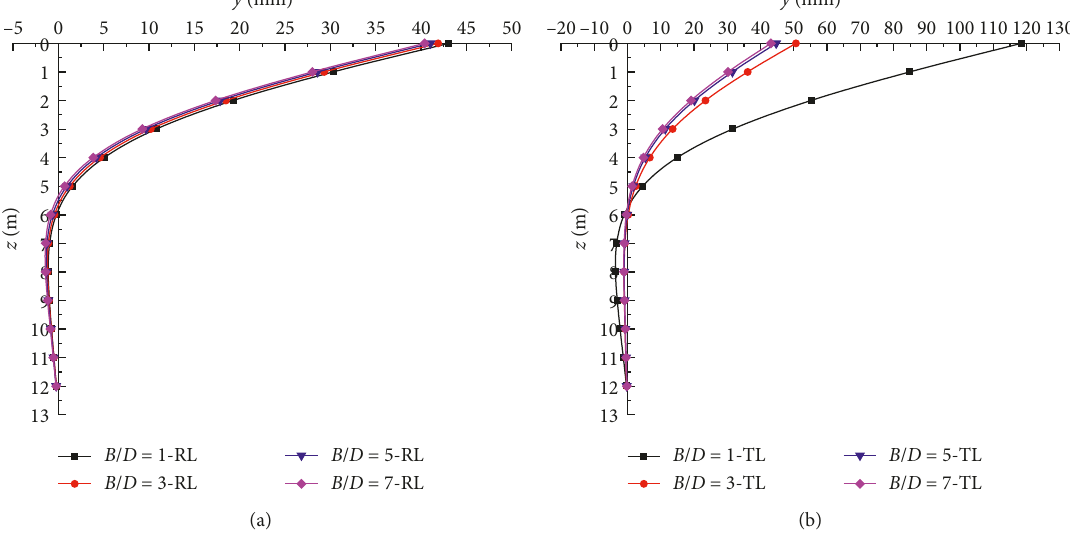
0 (cid:31) 500kN. (a) Reverse